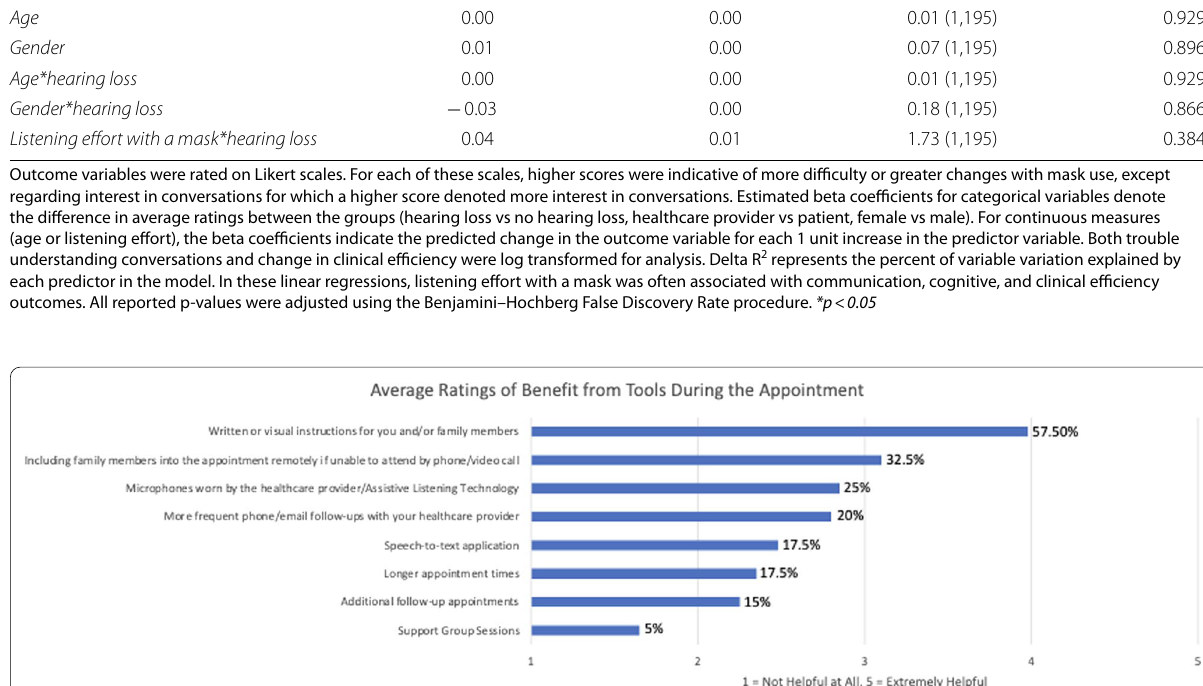
Fig. 1 Rehabilitative Strategies. Outcome variables were rated on Likert scales of 1 (not helpful at all) to 5 (extremely helpful). For each of these scales, higher scores were indicative of the more beneficial the given rehabilitative strategy would be to have during a medical